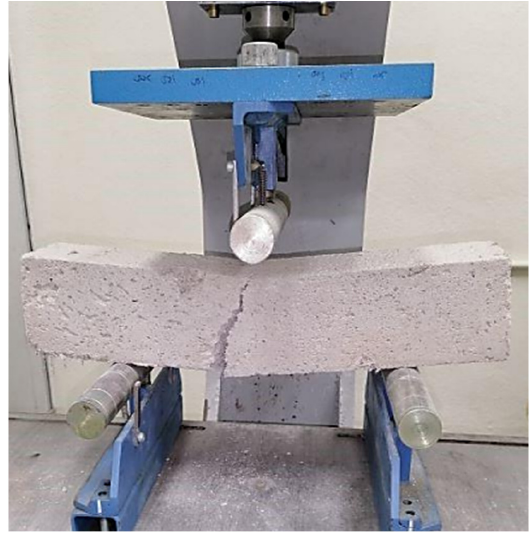
Figure 6. Apparatus for three-point bending test.